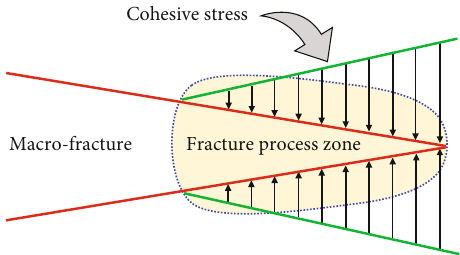
Figure 10: The fracture process zone ahead of the